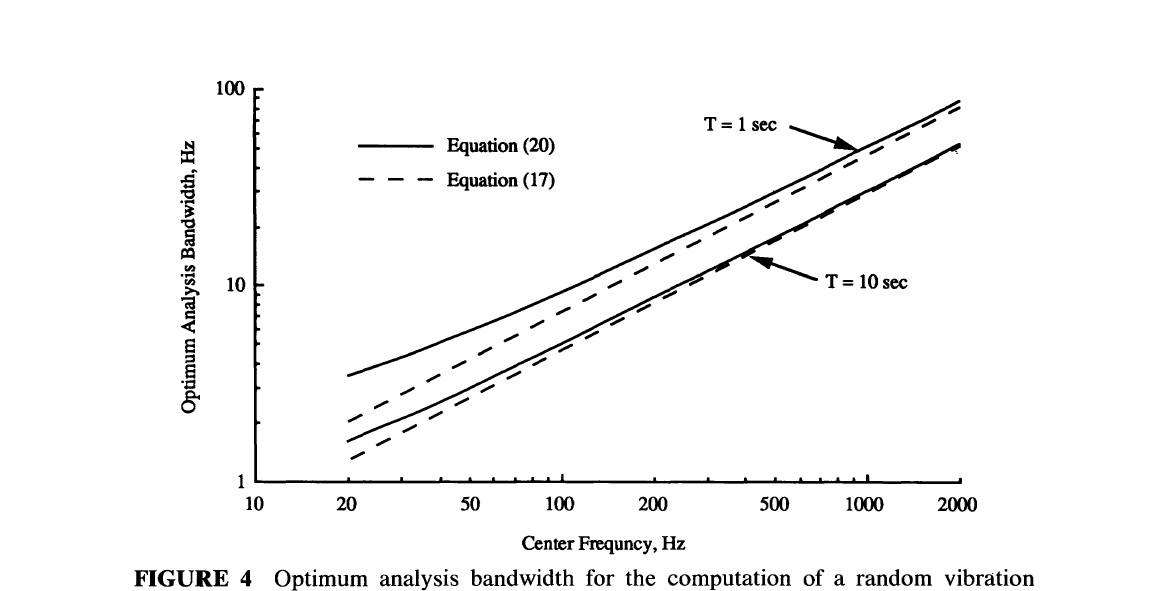
FIGURE 4 Optimum analysis bandwidth for the computation of a random vibration signal PSD (~ =